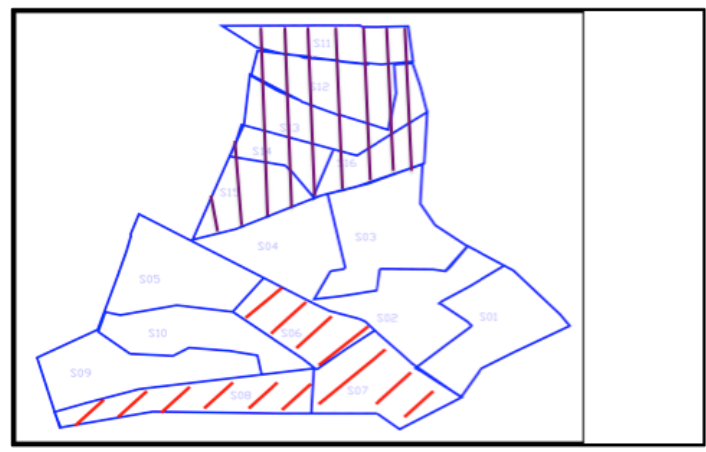
Table 1. Area and depth to water table by the 3 sub-regions (players).